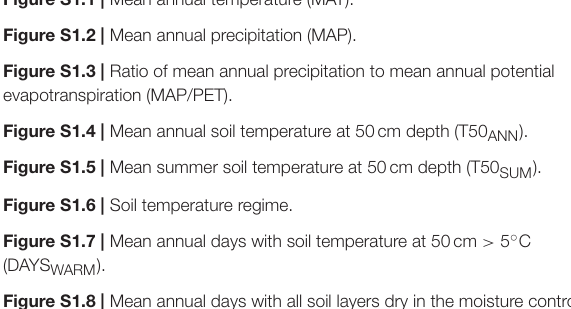
Figure S3.1 | (a,b) Mean annual soil temperature at 50cm depth (T50 ANN ). Figure S3.2 | Soil temperature regime. Figure S3.3 | (a,b) Mean annual proportion of days when soil temperature at 50cm > 5 ◦ C with all soil layers dry in the moisture control section (DRY PROP ). Figure S3.4 | (a,b) Mean annual number of consecutive days with all soil layers wet in the moisture control section during winter (CWET WINTER ). Figure S3.5 | (a,b) Mean annual number of consecutive days with all soil layers dry in the moisture control section during summer (CDRY SUMMER ). Figure S3.6 | Soil moisture regime. Figure S3.7 | Resistance class. Figure S3.8 | Resilience class. Figure S4.1 | Site-specific soil texture and moisture control section depth. Figure S4.2 | Projected change in warm & dry days vs. projected change in warm days. Gray background points show all changes RCP 8.5, 2070–2100